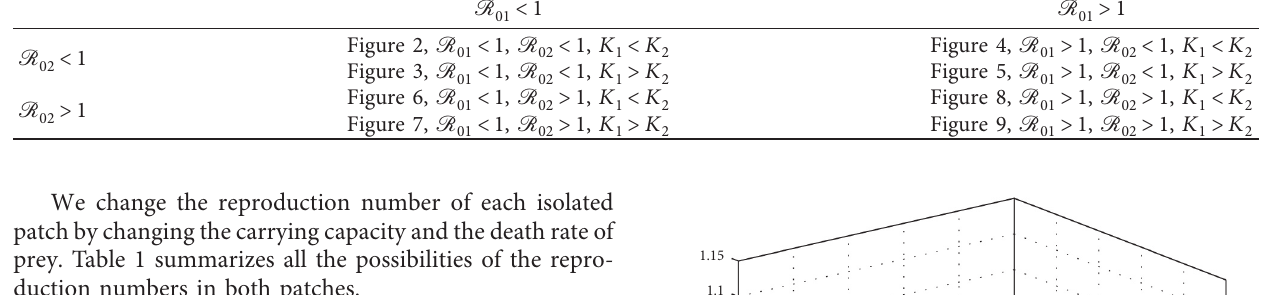
Table 1: The relationship of R